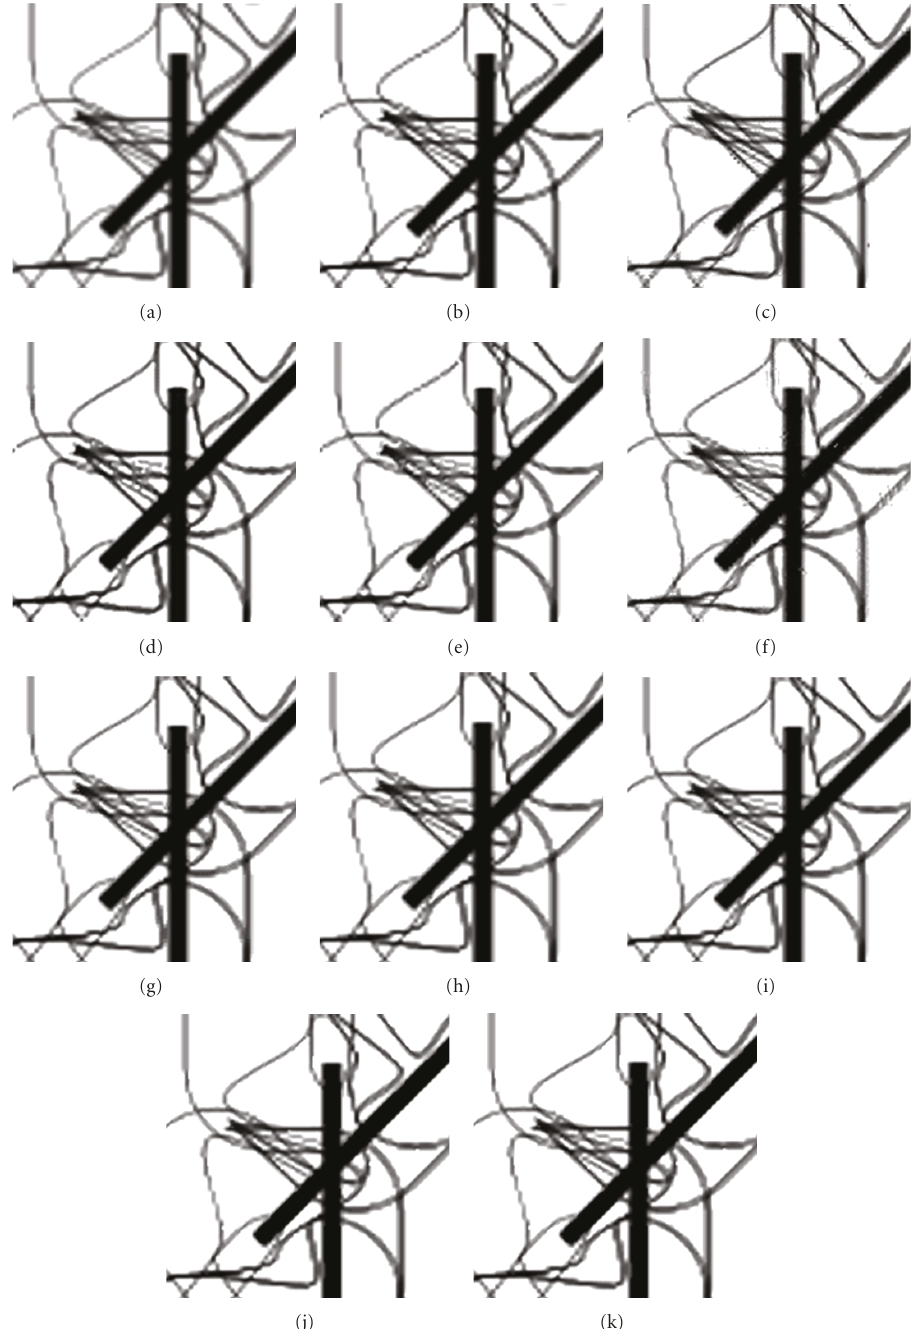
Figure 13: Portions of resolution enhanced “geometric motif 3 outline” image by (a) bilinear; (b) bicubic; (c) edge-directed method ( M = 8) [12]; (d) ICBI [20]; (e) LMMSE-based method ( ζ = 1, ξ = 1 . 5) [17]; (f) SAI ( λ = 0 . 5) [18]; (g) NN-based method [16]; the proposed method utilized (h) bilinear kernel and (i) bicubic kernel without edge enhancement; (j) bilinear kernel and (k) bicubic kernel with edge